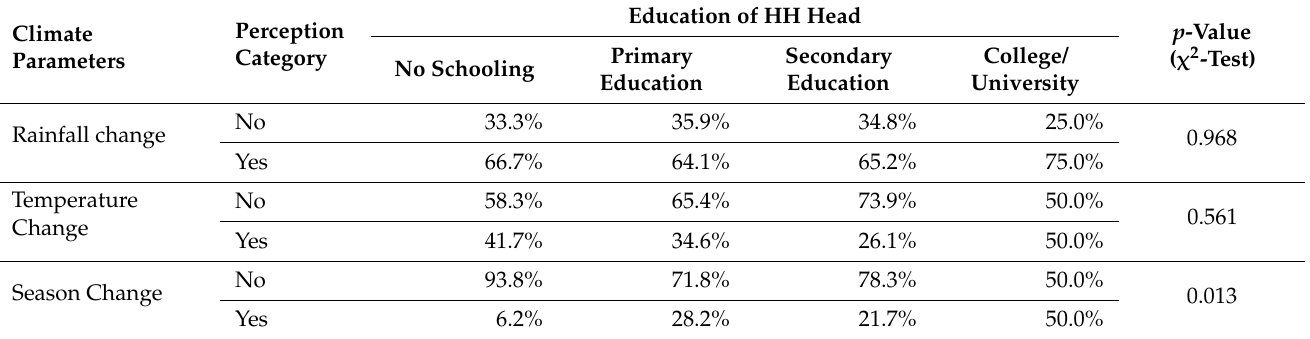
Table 4. Climate change perception by education category of the respondent in the study area.